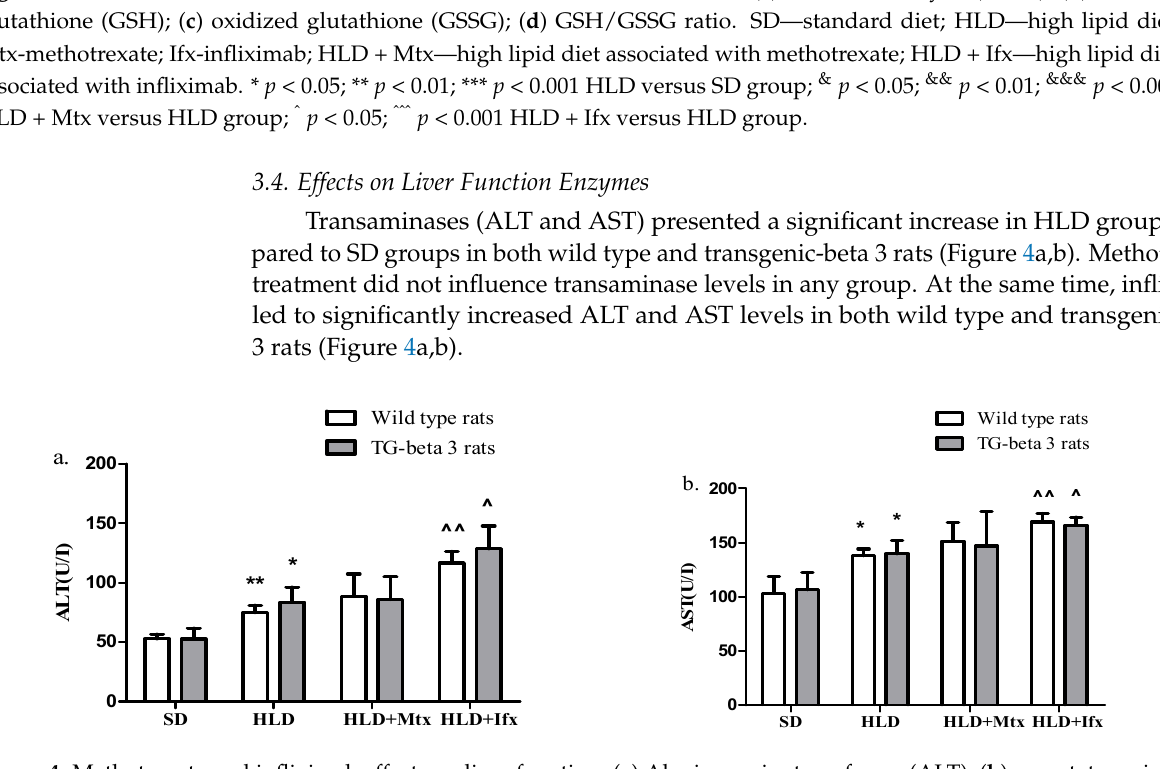
Figure 4. Methotrexate and infliximab effects on liver function. ( a ) Alanine aminotransferase (ALT), ( b ) aspartate amino- transferase (AST). SD—standard diet; HLD—high lipid diet; Mtx-methotrexate; Ifx-infliximab; HLD + Mtx—high lipid diet associated with methotrexate; HLD + Ifx—high lipid diet associated with infliximab. * p < 0.05; ** p < 0.01 HLD versus SD group; ˆ p < 0.05; ˆˆ p < 0.01 HLD + Ifx versus HLD